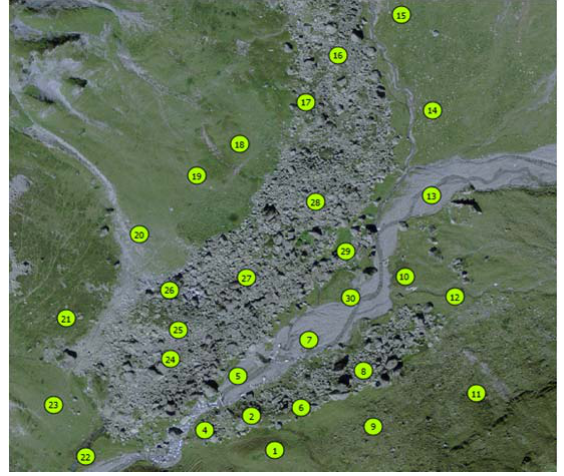
Figure 3: 30 Scan Positions for the Generation of the DSM The relative and absolute pose estimation of the scans was accomplished simultaneously. The scanner positions were measured with differential GNSS. The ground control points or additionally temporary marked points – also measured with GNSS - were used to provide the orientation. Therefore, all scans are directly transformed into the reference frame.